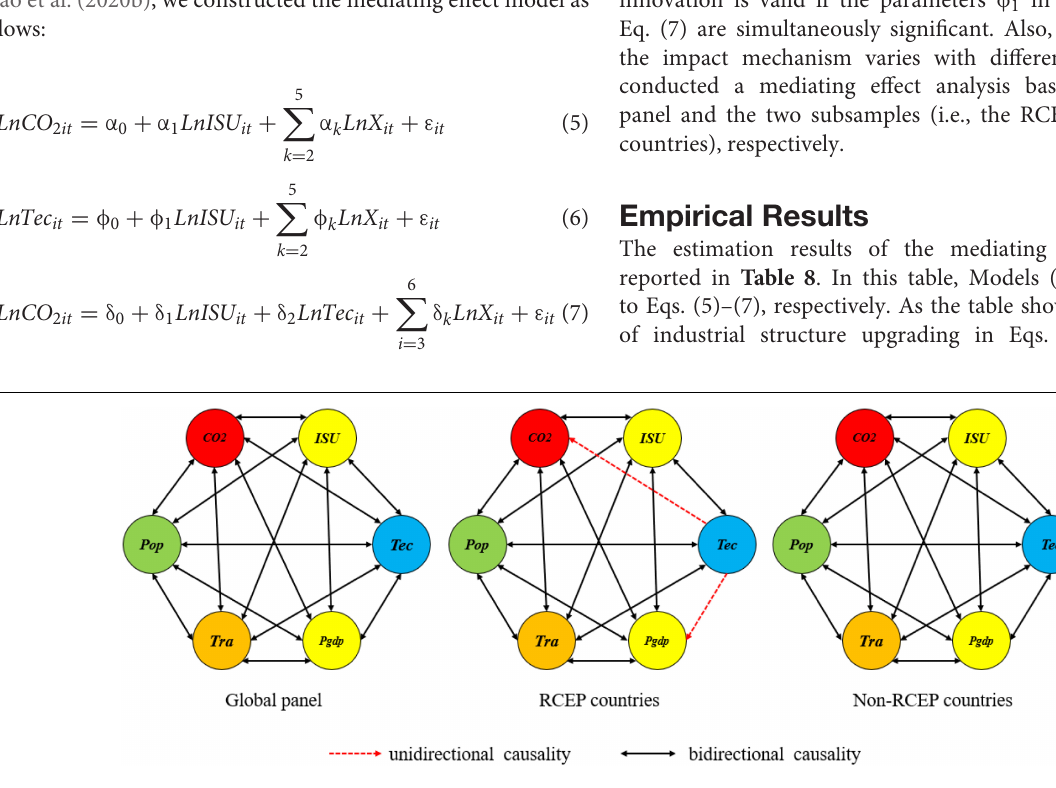
FIGURE 1 | Results of causality movements for the full panel and two subpanels.